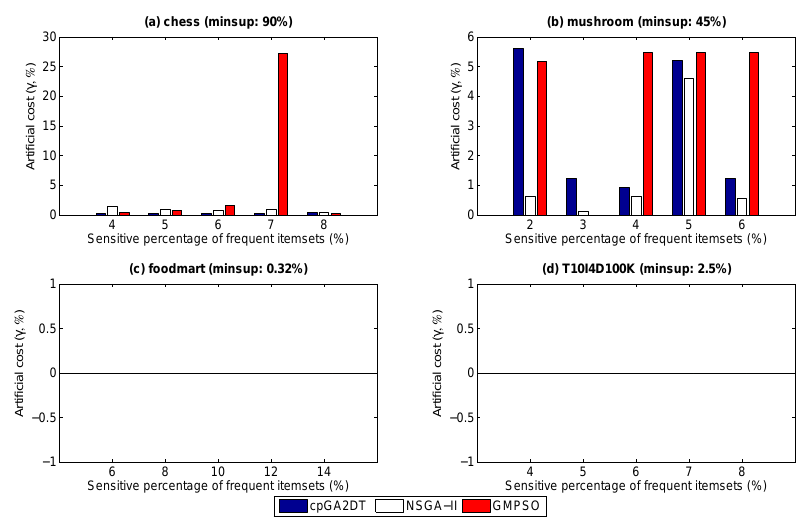
Figure 6. Artificial cost under varied percentages of sensitivity.